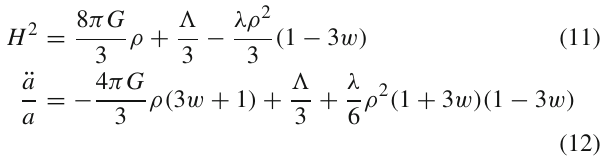
F (ρ) (cid:6) 2. For such a regime, the relativistic fluid